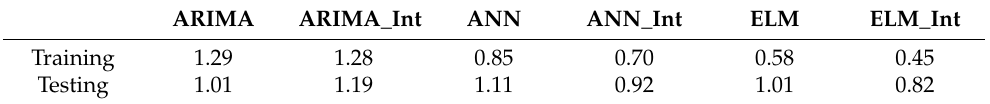
Table 6. Model performance in terms of MAPE in training and testing datasets.